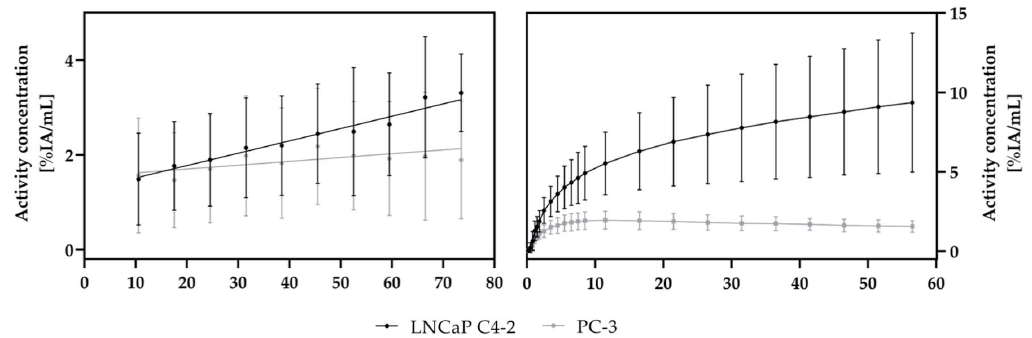
Figure 3. PET-data-based time-activity curves of [ 18 F]F-siPSMA-14 accumulation in tumor xenografts of the HET-CAM model ( left ) and the mouse model ( right ). An increasing activity concentration [%IA/mL] over 60 min scan time was observed for the PSMA + LNCaP C4-2 tumors in both models, whereas for PC-3 the signal was roughly constant. The resulting positive slope for LNCaP C4-2 indicates uptake of [ 18 F]F-siPSMA-14. VOIs were drawn on anatomical MR scans in the PET/MR fusion images. Depicted mean and standard deviation values were determined using all measured PET data (HET-CAM n = 26; mice n = 7). Linear regression lines are shown for the HET-CAM data ( left ), whereas connecting lines are shown for the mouse data ( right